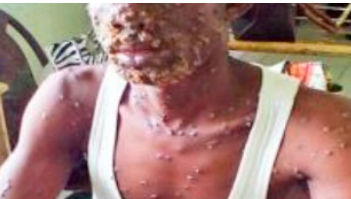
Figure 2. Extensive papulo ‐ pustular monkeypox rashes with crust and scar formation. (Courtesy of Figure 2. Extensive papulo-pustular monkeypox rashes with crust and scar formation. (Courtesy Nigeria Center for Disease Control, Abuja, Nigeria.) Reprinted with permission from Ref. [33]. Cop ‐ of Nigeria Center for Disease Control, Abuja, Nigeria.) Reprinted with permission from Ref. [33]. yright 2019 the Infectious Disease Clinics of North America. Copyright 2019 the Infectious Disease Clinics of North